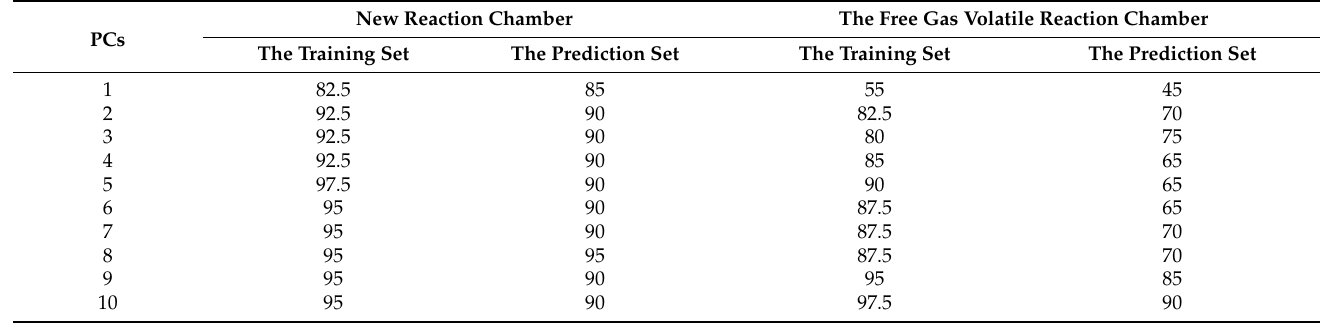
Table 2. Classification results by LDA in different reaction chambers